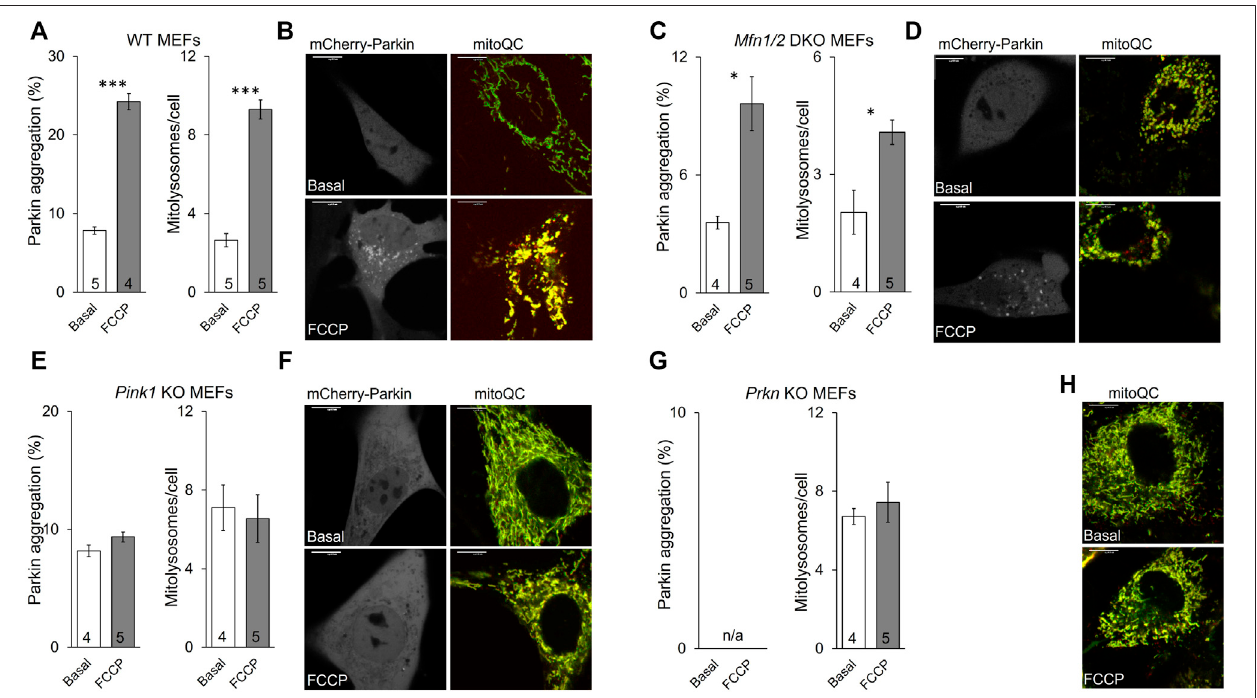
FIGURE 4 | Mitochondrial Parkin recruitment and mitolysosome formation in cells lacking different mitophagy factors. (A,B) , wild-type (WT) MEFs; (C,D) , Mfn1/2 DKO MEFs; (E,F) , Pink1 KO MEFs; (G,H) , Prkn KO MEFs. Parkin aggregation was assayed by visualization of virally expressed mcParkin in cells untreated (basal) or treated with FCCP (5 μ M, 1 h). Mitolysosome formation was measured with virally expressed mitoQC in cells untreated (basal) or treated with FCCP (5 μ M, 8 h). (A,C,E,G) show mean group data. Basal vs. FCCP treatment: p < 0.05 *; p < 0.01 **; p < 0.001***, all by student ’ s t-test. (B,D,F,H) are representative images for each cell type; different cells for basal and FCCP-treated conditions. Supplementary Figure S2 has channel-separated images for mitoQC. Note that Parkin aggregation cannot be measured in Prkn KO MEFs (n/a). MFN2 mutant phosphorylation effects are recapitulated in PINK1 de fi cient cells.